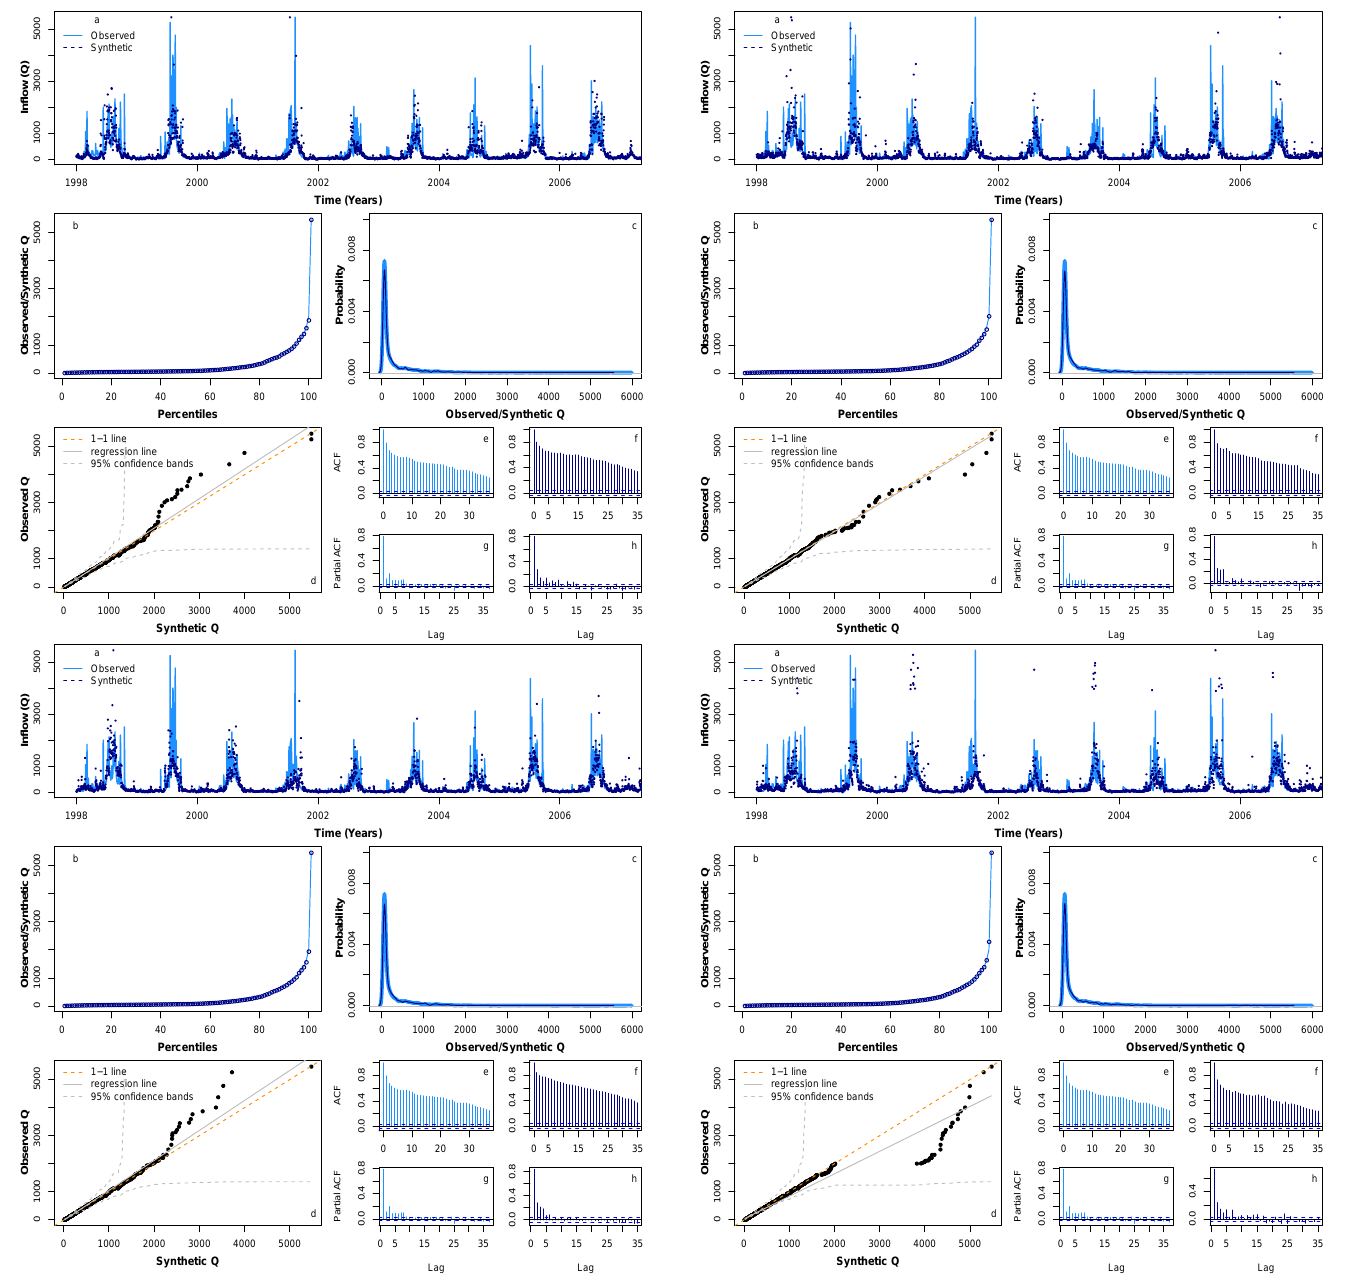
Figure A3. Comparison of four sample synthetic Q time series during the period 1998–2006. This figure is aimed to illustrate the performance of the model for additional four samples and is a cluster of four subfigures that contains 8 subsubfigure each (listed as a – h ) for consistency. See Figure 8 for individual figure